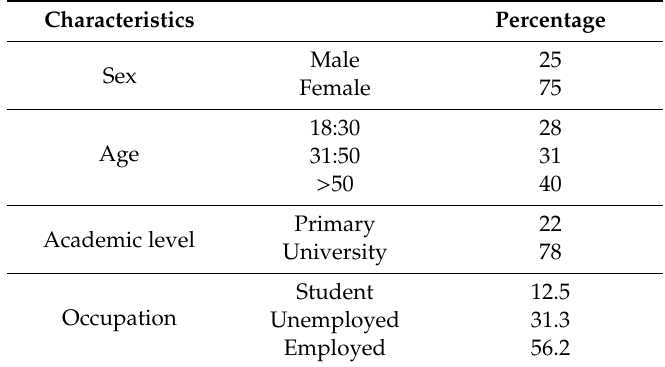
Table 1. Socio-demographic characteristics of